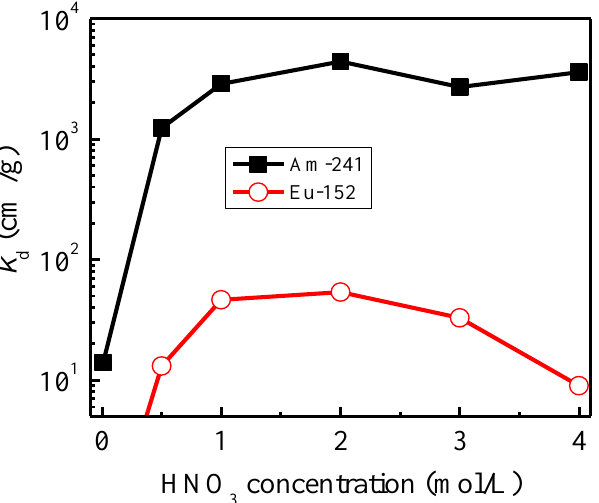
Figure 3. Effect of nitric acid concentration on the adsorption of 241 Am(III) and 152 Eu(III) onto iso Bu-BTP/SiO 2 -P (pH 2, 298 K, 24 h).